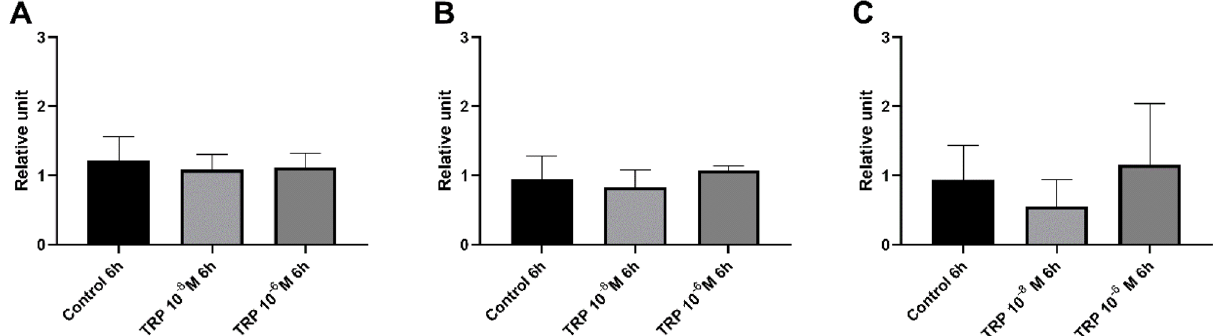
Figure 5. Reverse transcription quantitative PCR (RT-qPCR) analysis of the expression level of genes encoding selected antimicrobial peptides (( A ) attacin 2; ( B ) tenecin 3) and the Toll receptor ( C ) in immune-related tissues (pooled fat body and haemocytes) 6 h after Tenmo-TRP-7 application at concentrations of 10 –8 and 10 –6 M. The values are the means ± SEM.